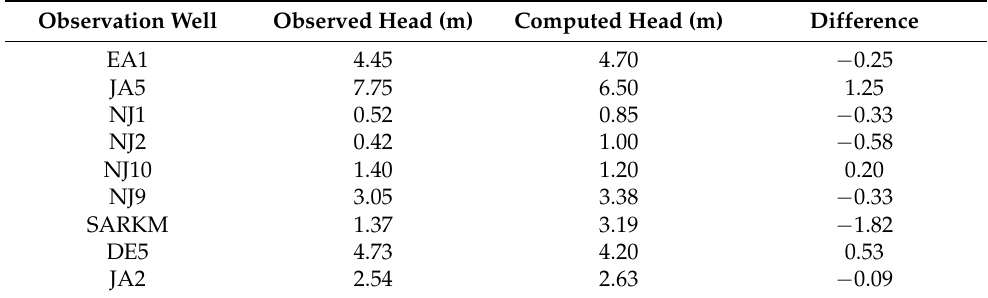
Table 3. Observed versus computed head for selected observation wells in the steady-state calibration for the year 2000.